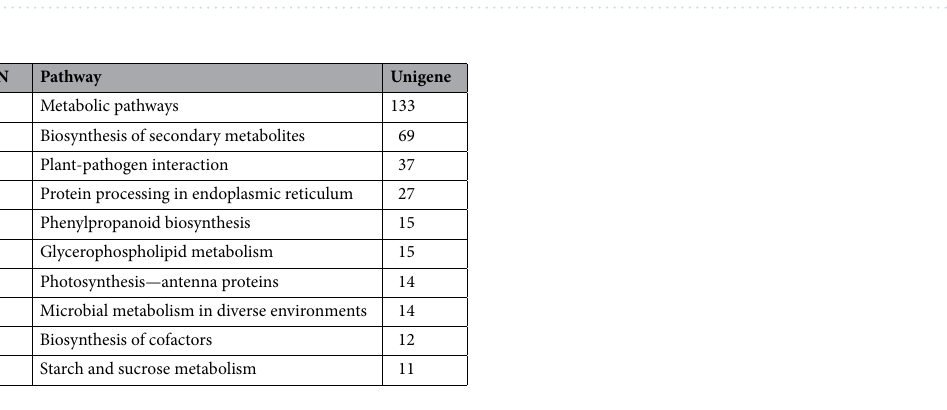
Table 2. List of top 10 pathways of DEGs during heat stress